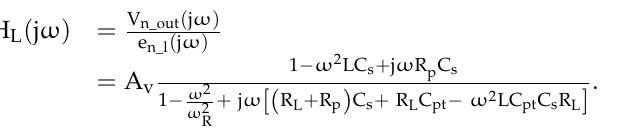
Figure 10. Peak of the output noise spectral density contribution due to R L as a function of R L itself. Using the set of parameters listed in Table 1, starting from low values of R L , this peak appears when R L ≅ 500 kΩ (dashed magenta and green curves in Figure 9), then increases up to R L ≅ 6 M Ω (Figure 10). Beyond this value, the peak decreases for increasing values of R L and the function S nL ( ω ) assumes lower values in the frequency range under inves- tigation. Figures 7 and 10 suggest that, at least for what concerns the noise contributions considered up to now, it is convenient to work with large values of the resistor R L be- cause the amplitude of the output signal increases with R L (see Figure 7) and the noise contribution due to this resistor decreases (see Figure 10), whereas the contribution from the thermal noise of R p has exactly the same frequency behavior of the signal.